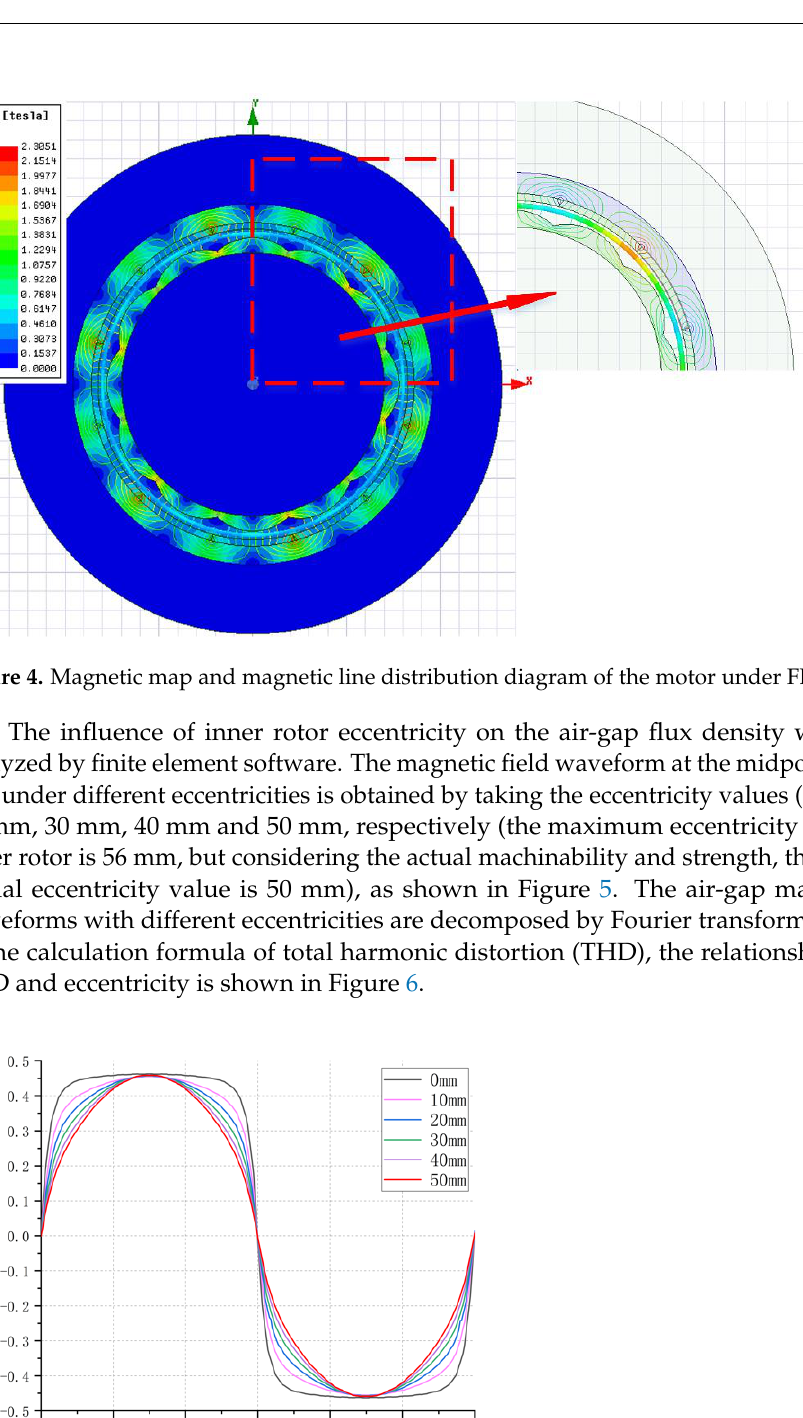
Figure 6. The THD with the air-gap magnetic field. From a comprehensive analysis of Figures 5 and 6, it can be seen that the THD grad- ually decreases with the increase of the eccentric value of the outer diameter of the inner rotor of the motor, indicating that the eccentric structure of the inner rotor can effectively reduce the total harmonic distortion, and the total harmonic distortion decreases with the increase of the eccentric value of the outer diameter of the inner rotor. Therefore, the ec- centric value of 50 mm is selected as the optimal solution. With the increase of eccentricity, the air-gap magnetic field waveform gradually ap- proaches the sine wave, which is due to the increase of magnetic resistance due to the thickening of the air gap caused by the local thinning of the rotor, thus reducing the air- gap magnetic field between the thinning area of the inner rotor and the two sides of each PM. At the same time, due to the special design of the “ petal ” shape of the inner rotor, the air-gap magnetic field between the inner rotor and the center of each PM remains un- changed and finally brings the air-gap magnetic field waveform closer to the sine wave. Figures 7 and 8 show the air-gap magnetic field waveform and Fourier spectrum be- fore and after optimization under the condition of an eccentricity value of 50 mm.